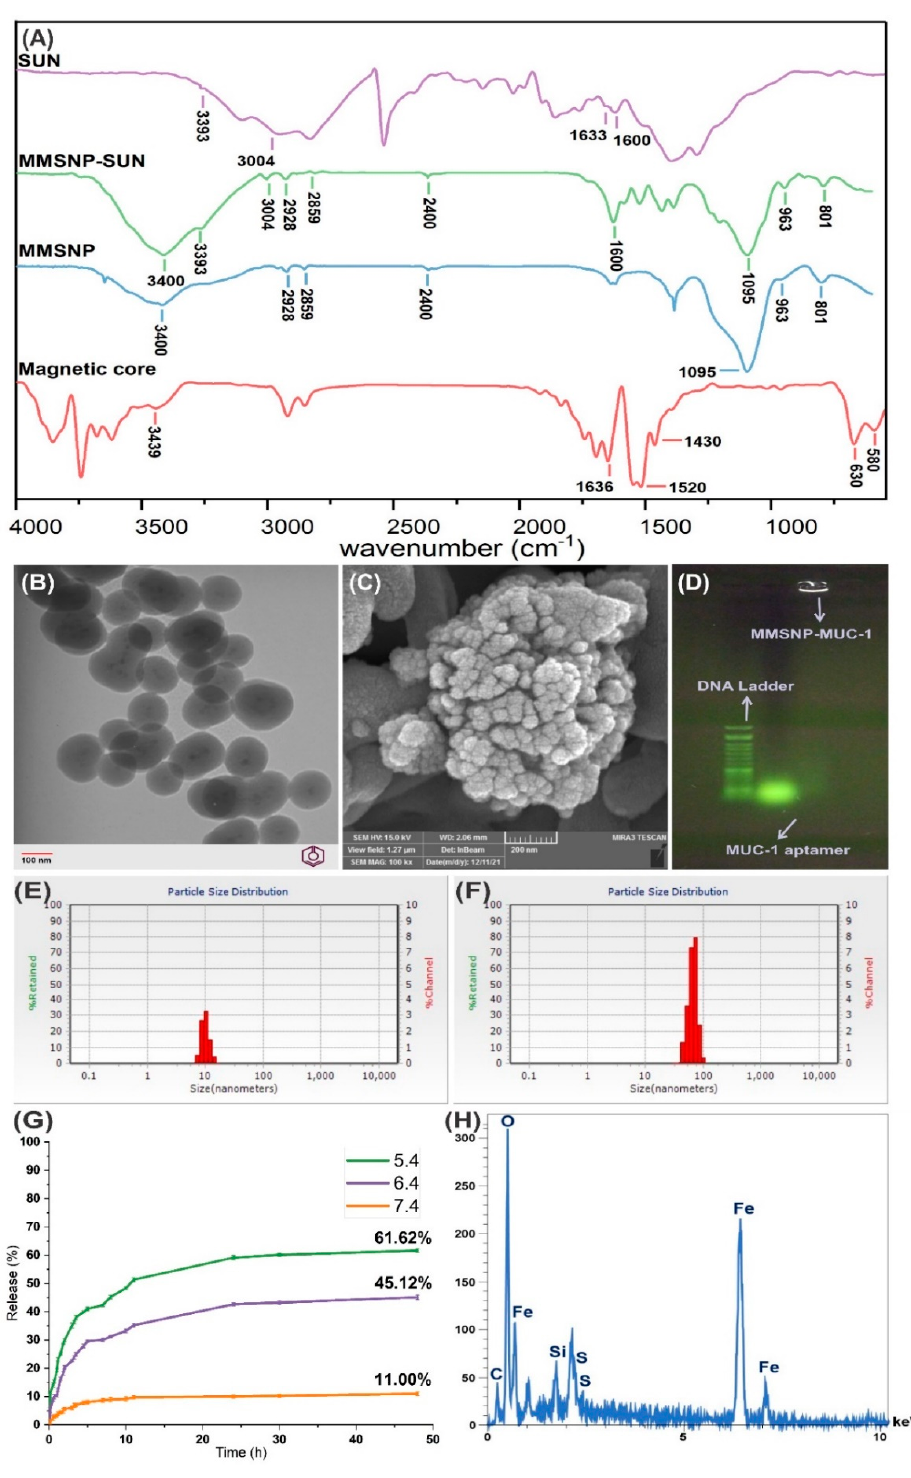
Figure 2. Physicochemical characterization of NCs; FT − IR spectra of the magnetic core, MMSNP, MMSNP − SUN, and SUN ( A ). TEM image and SEM image of the MMSNP ( B , C ). The gel electrophoresis analysis of aptamer armed MMSNP; The size of the DNA ladder applied in gel electrophoresis was 50 bp ( D ). The size distribution of the magnetic core and MMSNP − SUN, respectively ( E , F ). SUN release profile from MMSNP − SUN in phosphate buffer with different pH values (i.e., 7.4, 6.4 and 5.4) at 37 °C during 48 h ( G ). The EDX spectrum of the MMSNPs ( H ). The scale bar of TEM represents 100 nm and the scale bar of SEM represents 200 nm.